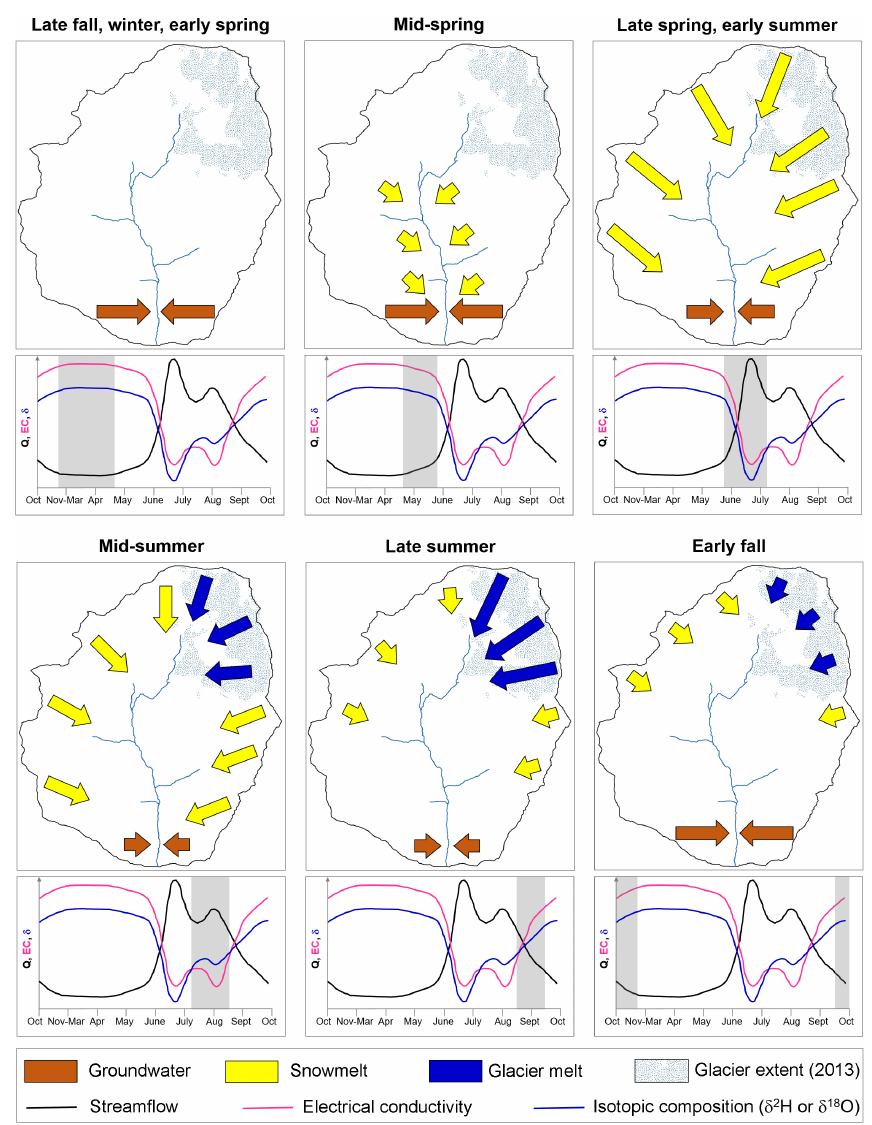
Figure 9. Conceptual model of the seasonal evolution of streamflow contributions in the Saldur River catchment (closed at LSG). The top subplots in each panel represent the water contributions to streamflow, and the size of the arrows is roughly proportional to the intensity of water fluxes. The bottom subplots show a sketch hydrograph along with EC and isotopic composition of stream water, and the shaded areas indicate time periods corresponding to the top subplots. The winter months, approximately between November and March, when the catchment is in a quiescent state and no significant hydrological dynamics is assumed to occur, are compacted in order to give more space to the other